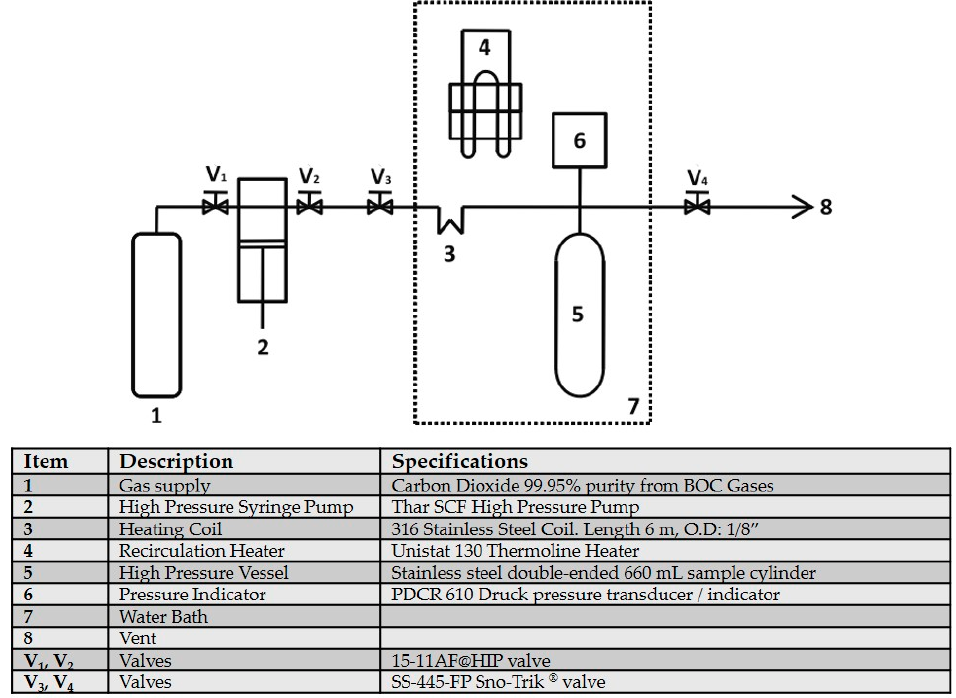
Figure 6. Schematic of the in-house supercritical fluid system [76].